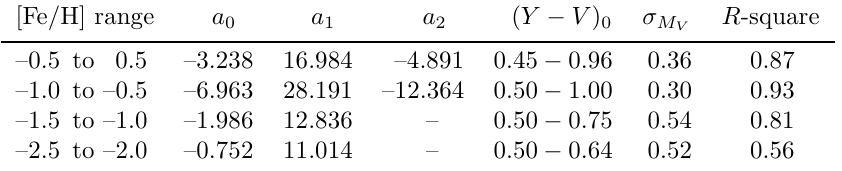
Table 1. The coefficients a 0 , a 1 and a 2 of relation (1) for different ranges of